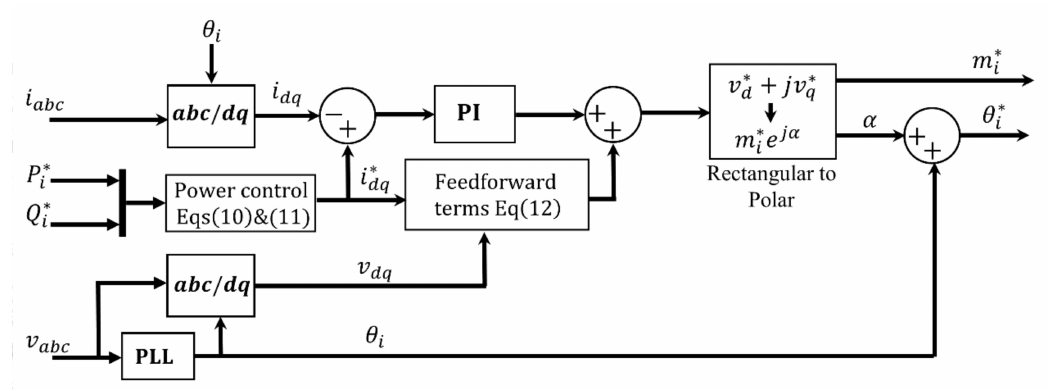
Figure 5. Active and reactive power control of RESi side